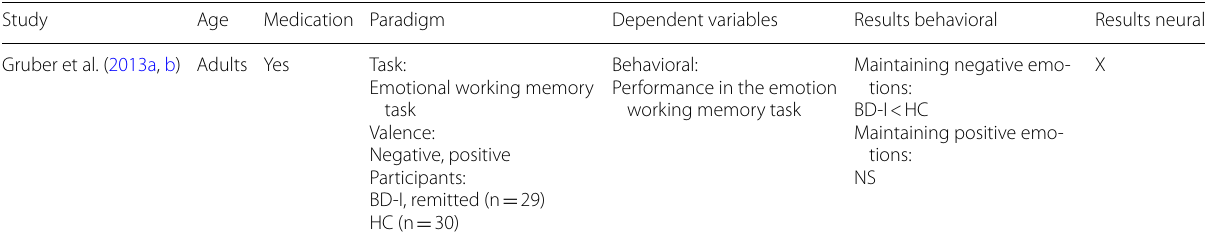
Table 1 Studies that investigated the maintenance of emotions in euthymic BD patients